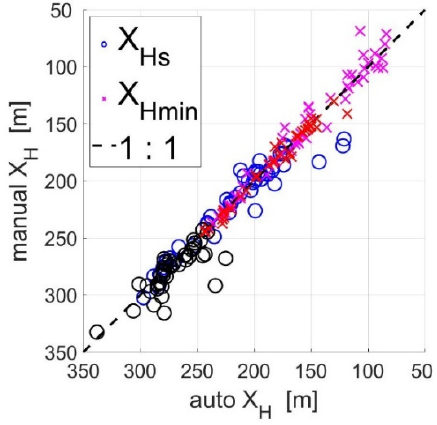
Figure 9. Comparison between 𝑋 (cid:3009)(cid:3046) Comparison between X Hs and X Hmin found from manual analysis of Timestacks, and automatically derived from I px . Circles represent X Hs (blue and black from 28 and 29 March, respectively), crosses to X Hmin (magenta and red from 28 and 29 March,